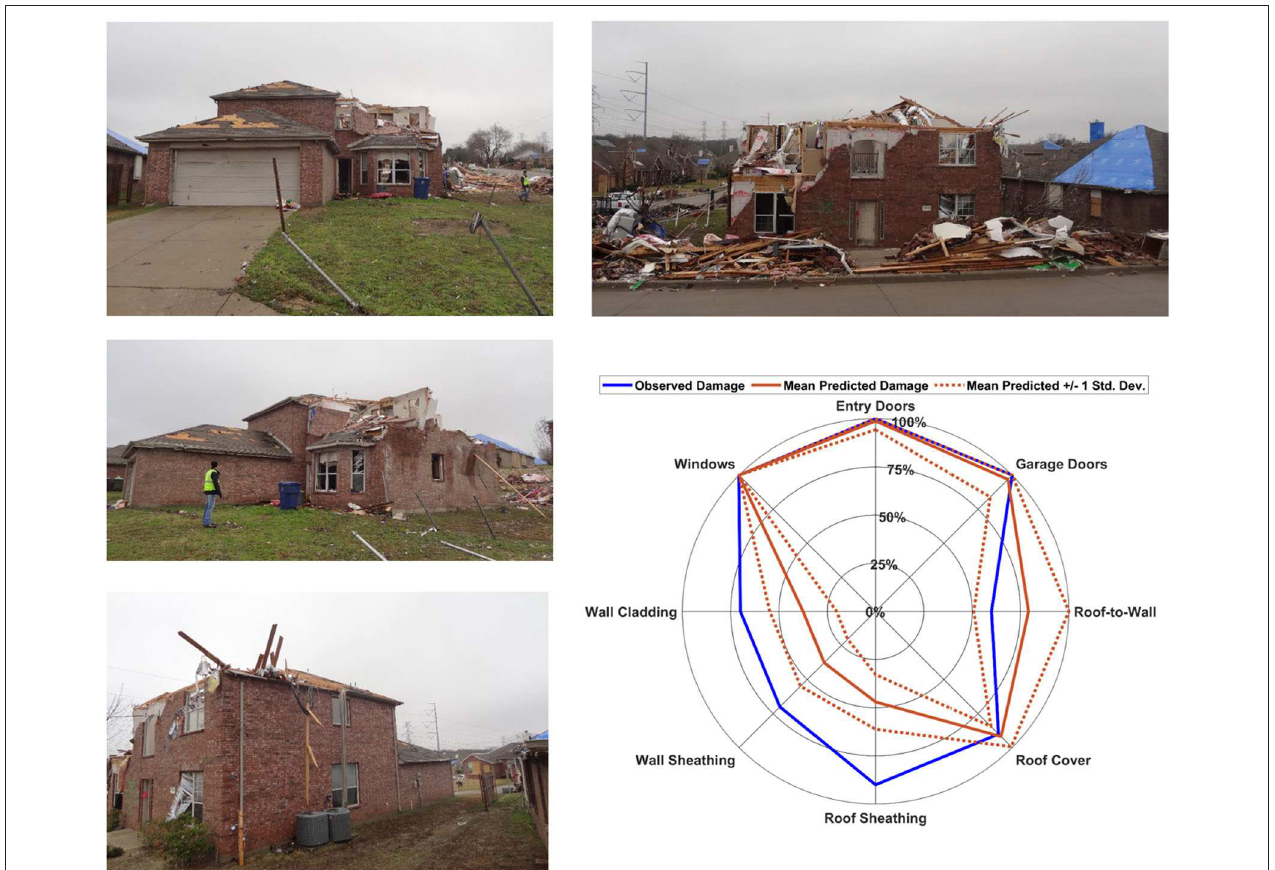
FIGURE 2 | Spider plot and post tornado photographs of a single-family home damaged in the 2015 Garland/Rowlett, TX, tornado.